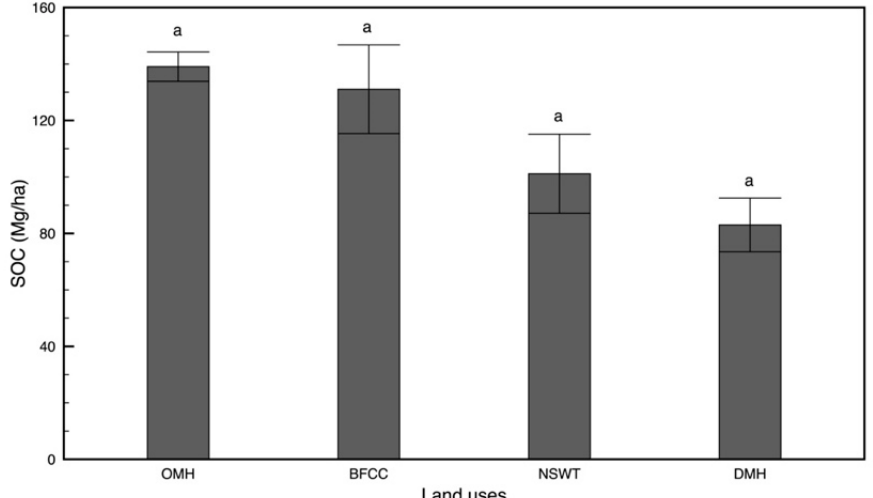
Figure 4. Soil organic carbon (SOC) stock at a 0–30 cm depth in the four dominant land uses at Santuario de Fauna y Flora Iguaque , Boyacá, Colombia. OMH: open heathlands and moorlands; BFCC: broad-leaved forests with continuous canopy, not on mire; NSWT: natural grasslands prevailingly without trees and shrubs; DMH: dense heathlands and moorlands. Error bars correspond to standard error. Equal letters indicate that there are no statistical differences ( p > 0.05) among land uses.